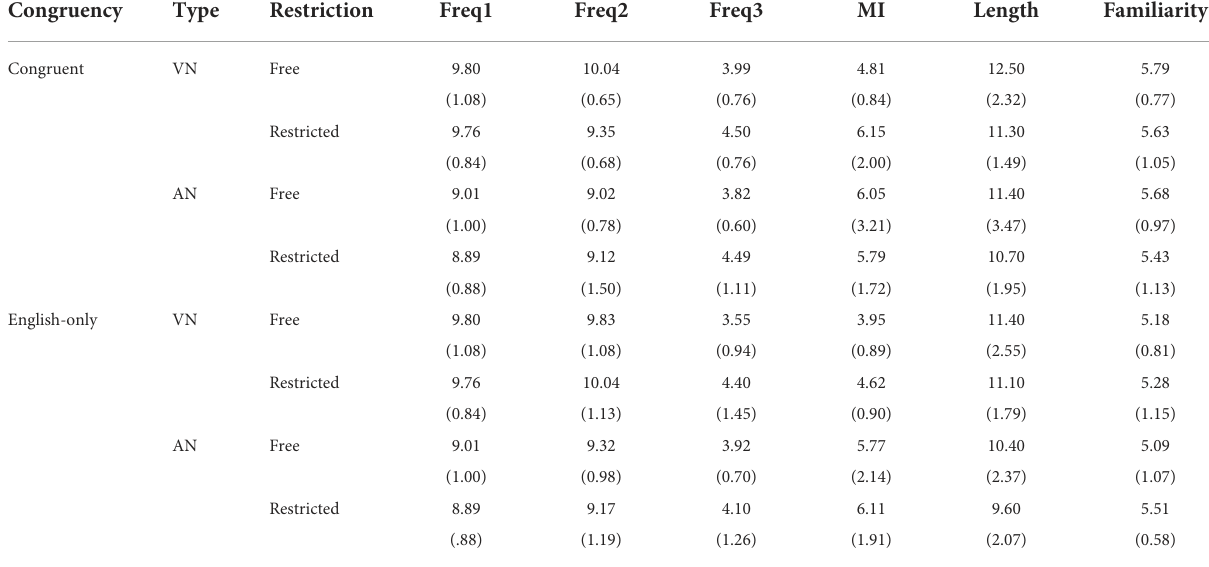
TABLE 1 Summary of test items means (with standard deviations in parentheses).